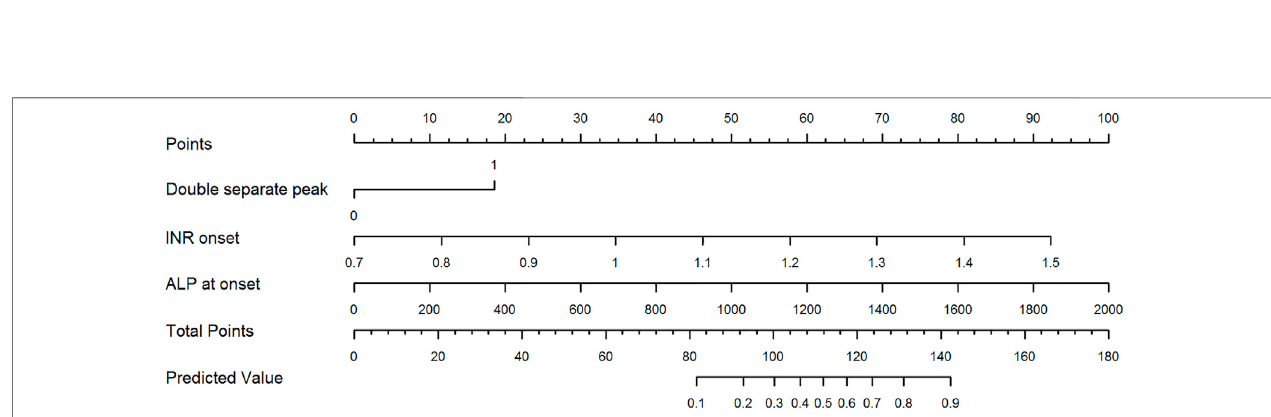
FIGURE4| OptimizeddoubleseparatepeakmodelwithINRandALPatDILIonset.Pointsareassignedfordoubleseparatepeak,INR,andALPatDILIonsetusing the linear points scale at the top of the fi gure. The risk of acute liver failure correlating with the total points is on the two linear scales at the bottom of the fi gure. Abbreviations: ALP, alkaline phosphatase; INR, international normalized ratio.